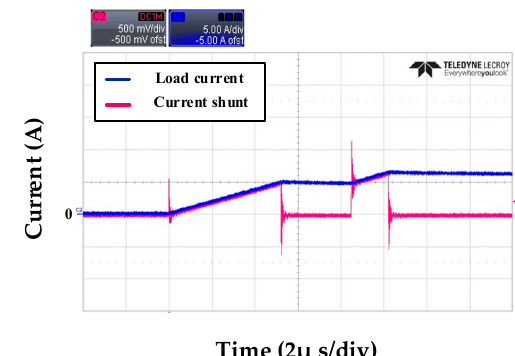
Figure 11. Prototype board of double pulse test: ( a ) current shunt; ( b ) daughter board with pick-up coil; ( c ) overall double pulse test board.